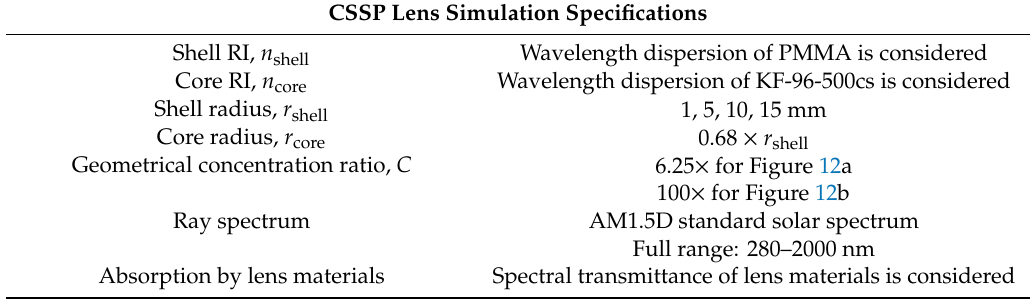
Table 6. Simulation conditions C.